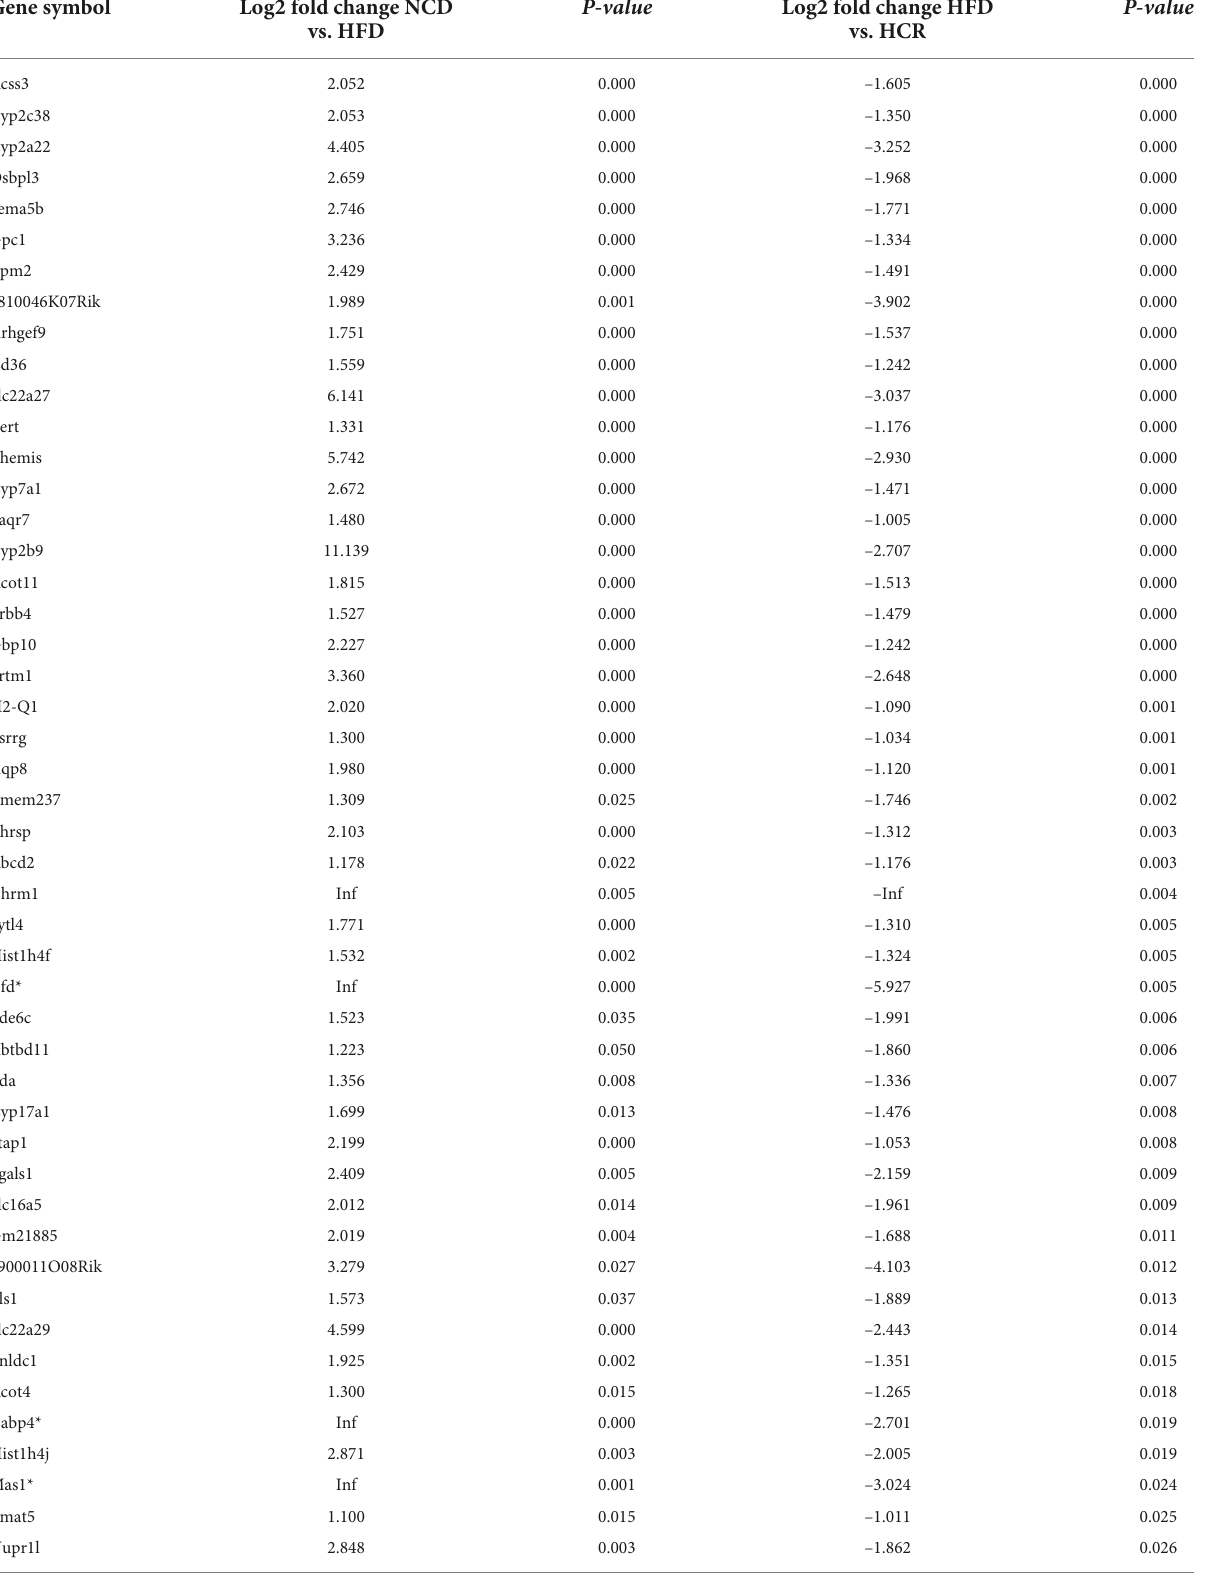
TABLE 3 The down-regulated DEGs in livers by treatment with